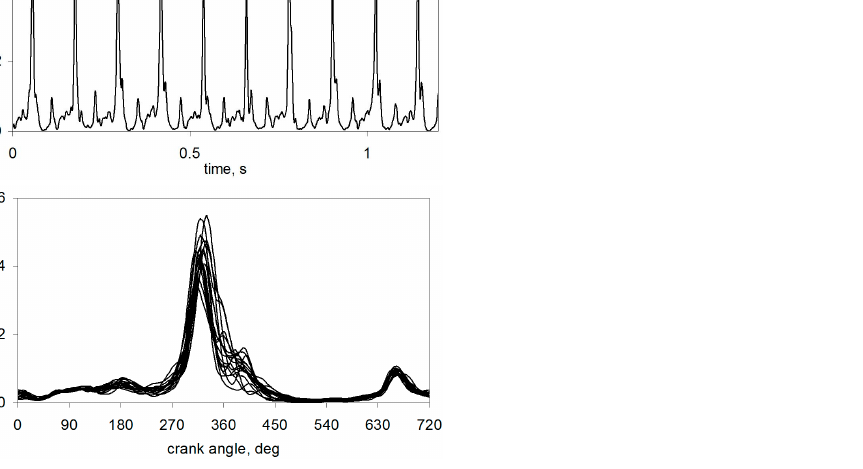
Figure 1. Speeds of the fresh charge in the combustion chamber of the SI engine [36].